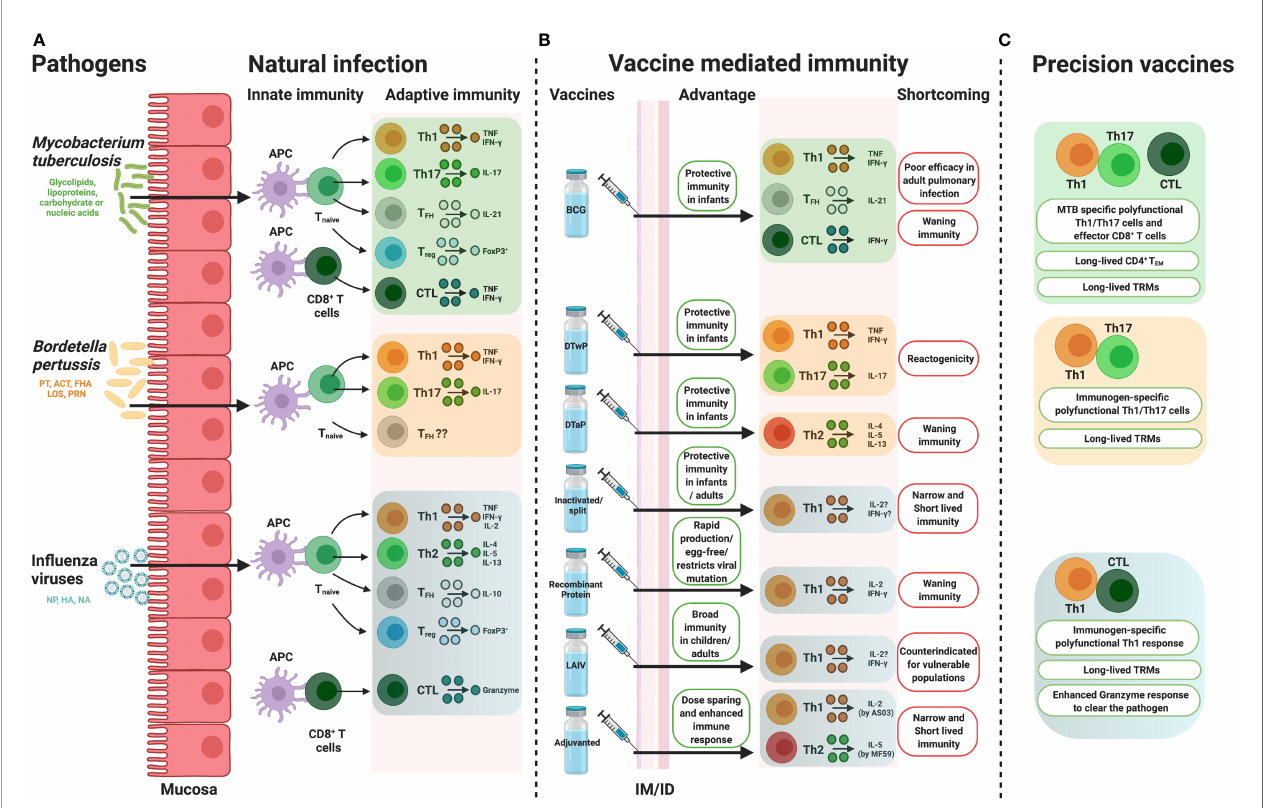
FIGURE 1 | How precision vaccine design takes cues from natural immunity. Overview of the immune responses, portraying from the perspective of conventional T cell biology, induced by (A) natural infection, (B) pathogen speci fi c vaccines along with their potential advantages and shortcomings and (C) possible hypothesis to overcoming the disadvantages by precision vaccine design. APC, antigen presenting cell, Th, T helper, IL, interleukin, TNF, tumor necrosis factor, T FH , follicular helper T cell, Treg, regulatory T cells, CTL, cytotoxic CD8 + T cell, BCG, Bacille Calmette-Gue ́ rin, DTwP, Diphtheria and Tetanus Toxoids along with Whole Cell Pertussis, DTaP, Diphtheria and Tetanus Toxoids along with Acellular Pertussis, LAIV, live attenuated in fl uenza virus, IM, intramuscular, ID, intradermal, IFN, interferon, PT, pertussis toxin, ACT, Adenylate Cyclase Toxin, FHA, fi lamentous hemagglutinin, LOS, lipo-oligosaccharide, PRN, pertactin, HA, haemagglutinin, NA, neuraminidase, NP, nucleoprotein, TEM, effector memory T cell, TRM, tissue resident memory T cells. Figure is created with